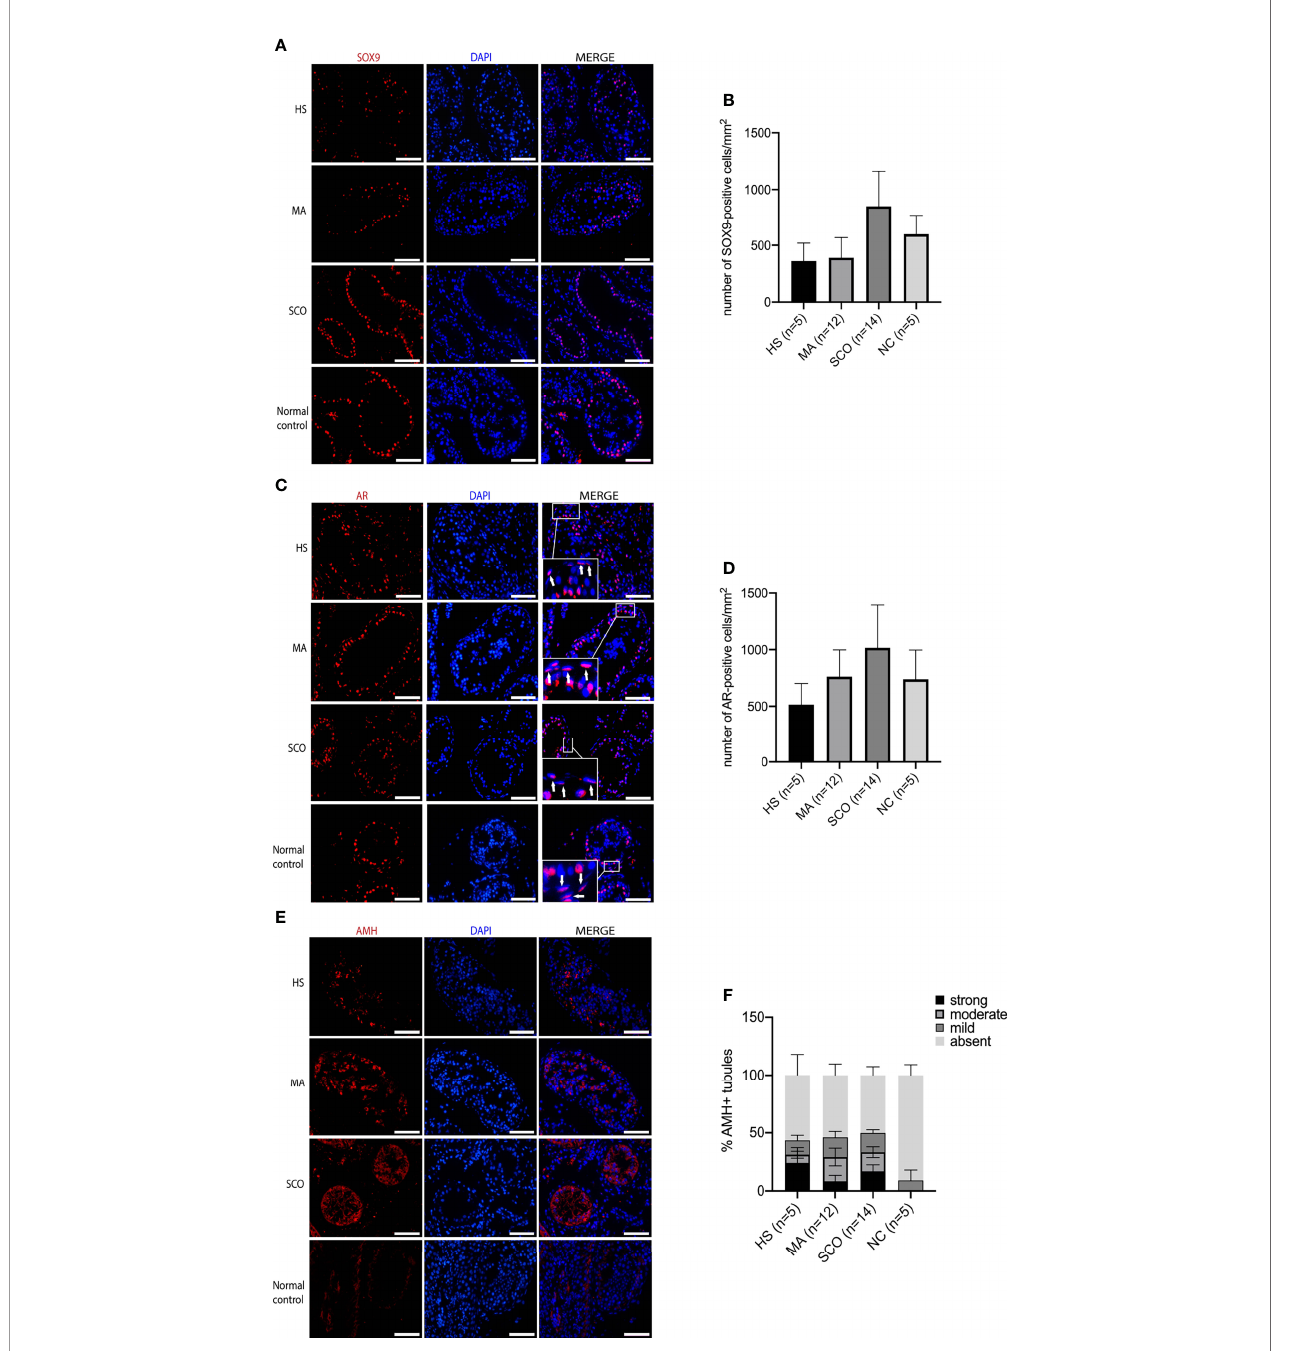
FIGURE 1 | Immuno fl uorescence staining of Sertoli cell markers in un-dilated seminiferous tubules from hypospermatogenesis (HS), maturation arrest (MA), Sertoli cell only (SCO), and normal control (NC) samples. (A) Sox9 (red) for Sertoli cells. (B) The number of Sox9-positive cells per mm 2 was counted from ten tubules of each biopsy. (C) AR (red) for mature Sertoli cells, white arrow indicated that AR also expressed in PTMCs. (D) AR-positive cells per mm 2 was counted from ten tubules of each biopsy. (E) AMH (red) for immature Sertoli cells. (F) AMH staining was categorized into “ strong ” “ moderate ” “ mild ” “ absent ” based on staining intensity. The percentage of AMH-positive tubules (including strong, moderate, mild expression of AMH) showed signi fi cant increase in HS, MA, and SCO comparing to normal control group. The percentage of tubules with “ strong ” AMH expression in each NOA subtypes was signi fi cantly increased to normal control (HS: P < 0.001, MA: P = 0.001, SCO: P < 0.001). The percentage of tubules with “ moderate ” AMH expression in each NOA subtypes was also signi fi cantly increased (HS, MA, SCO: P < 0.001). The percentage of “ mild ” AMH expression only signi fi cantly increased in SCO ( P = 0.006). DAPI (blue) for nuclear staining. Scale bar: 100 m m. n represent the number of individuals